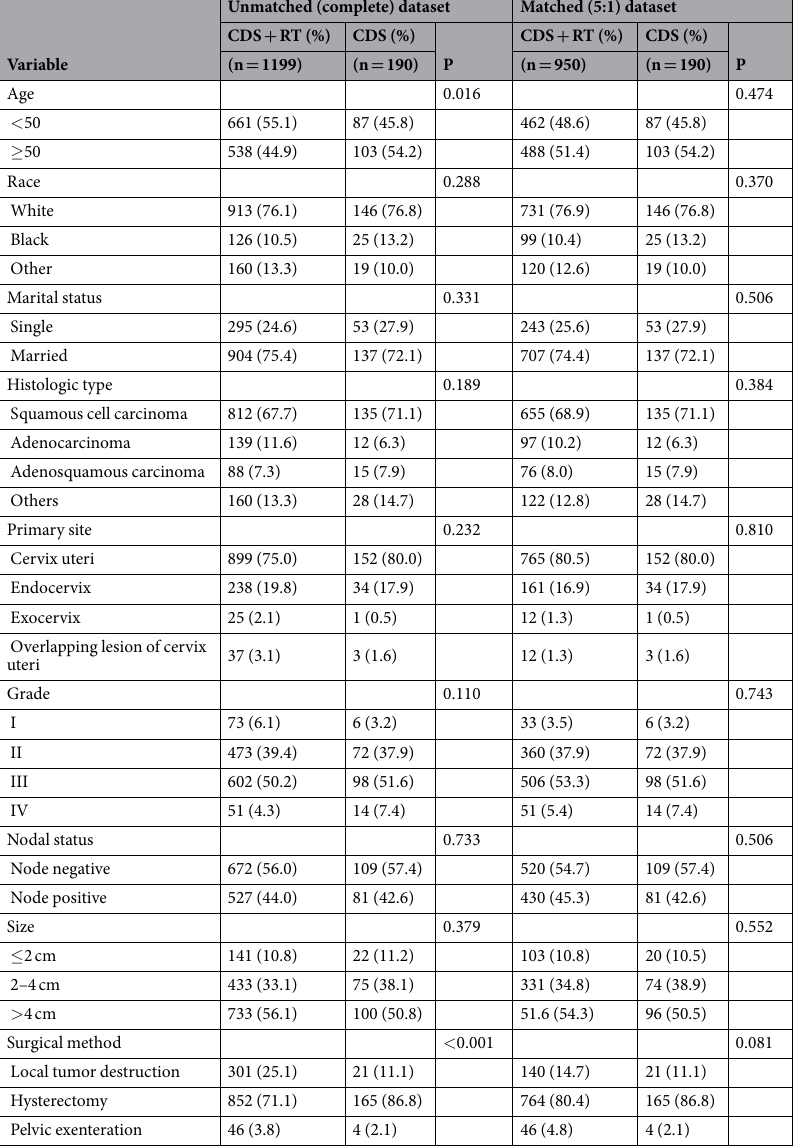
Table 4. Baseline characteristics of PSM cohorts for FIGO stage IIB. CDS: cancer-directed surgery; RT: radiotherapy.